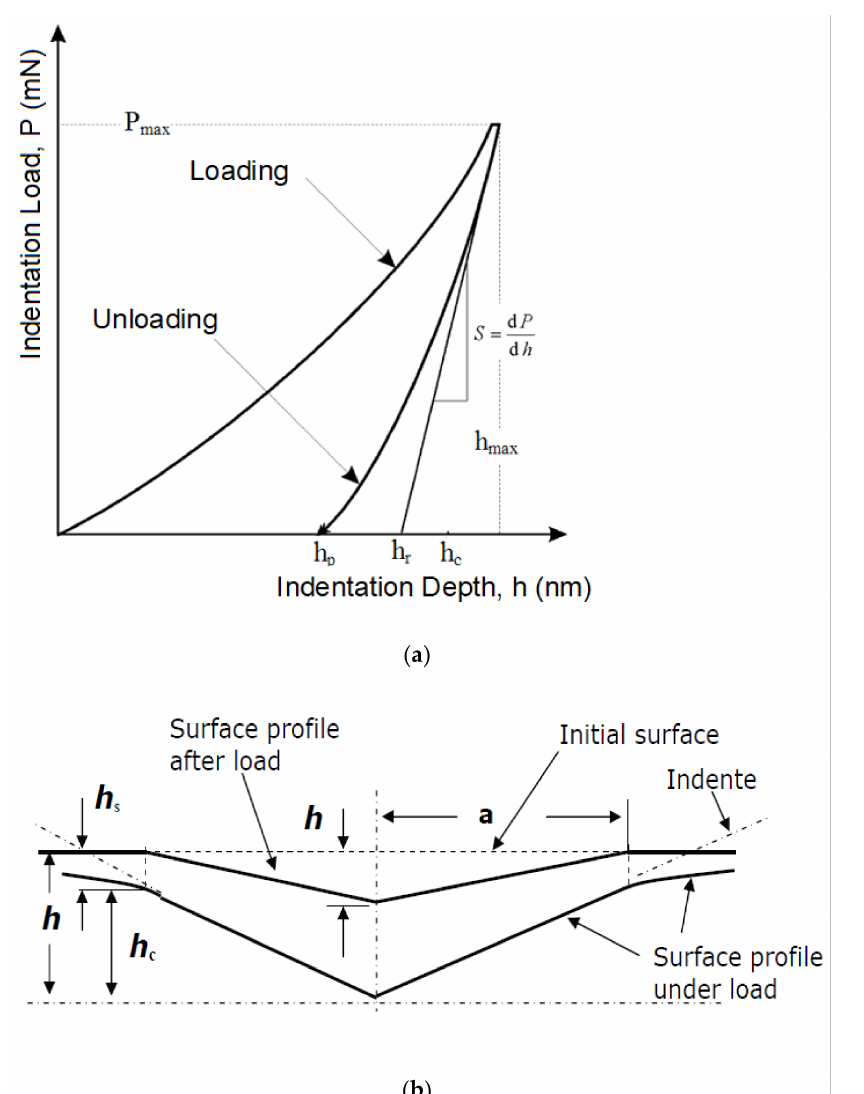
Figure A2. ( a ) Load–displacement curve, showing the values used in the Oliver and Pharr method; ( b ) cross-section of an